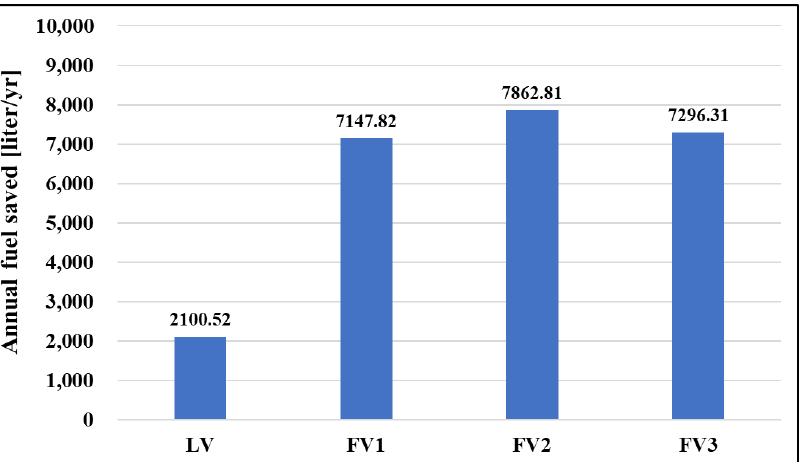
Figure 10. Annual fuel saving on the model vehicles platooning compared to the single moving vehicle (SV) at a 0.5 L gap.